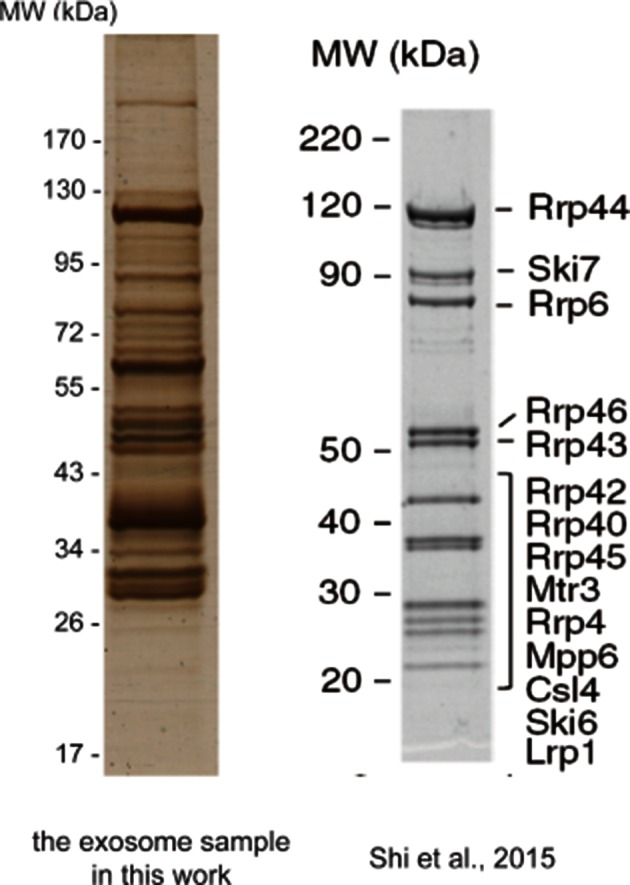
Silver-stained SDS-PAGE of the crude immunoprecipitate of TAP-tagged Rrp46 (left) and the SDS-PAGE of the purified exosome sample of Shi et al. (right).